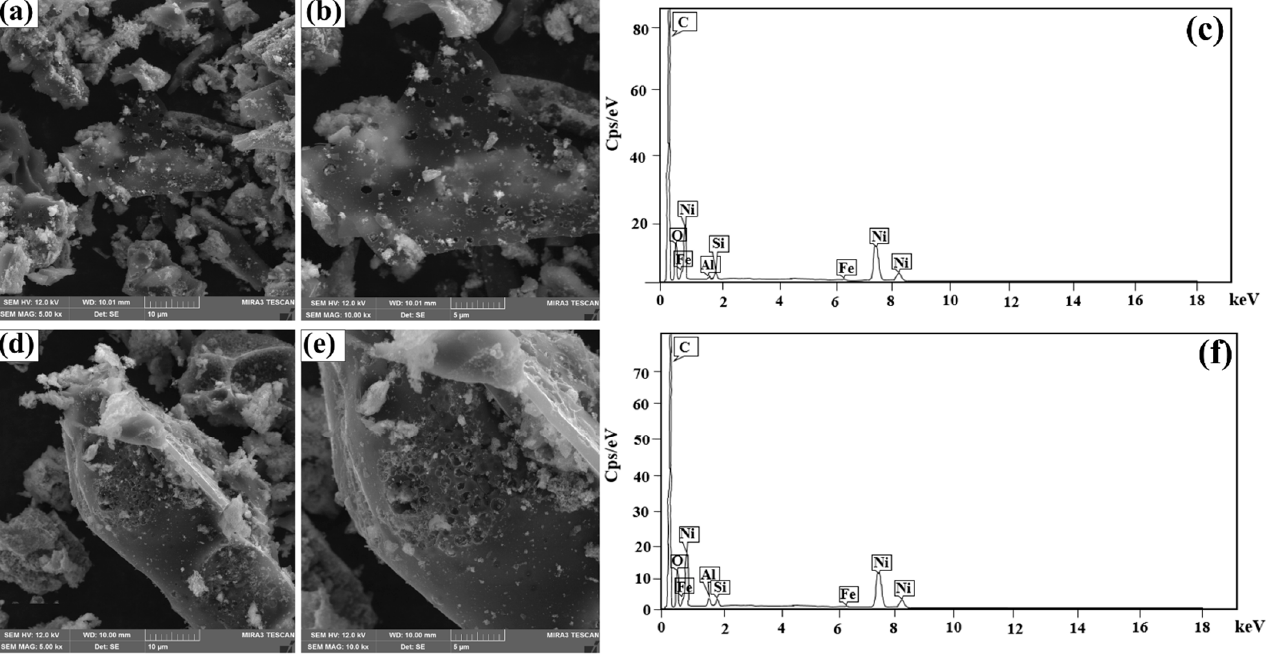
Figure 1. ( a , b ) SEM images and ( c ) EDS spectrum of MAC1105 and ( d , e ) SEM images and ( f ) EDS spectrum MAC111.